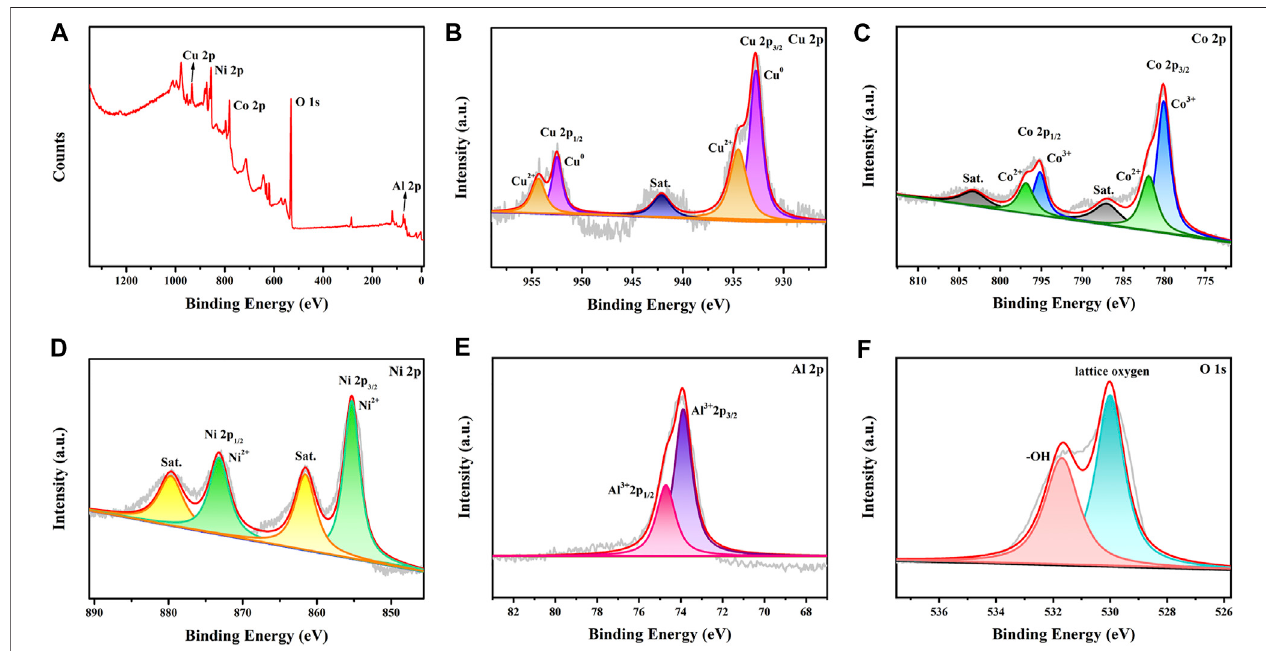
FIGURE5| XPSspectraforCuCoNiAl-MMOsamples: (A) surveyspectrum; (B) Cu2pspectrum; (C) Co2pspectrum; (D) Ni2pspectrum; (E) Al2pspectrumand (F) O 1s spectrum.